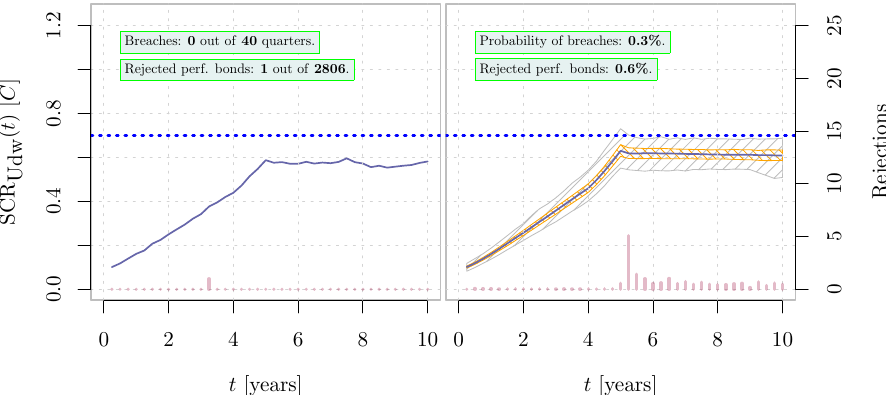
Figure 6. Dynamics of SCR Udw ( t ) , given the notation introduced in Figure 4. RAF introduced in Definition 2 is applied to estabilish the management actions